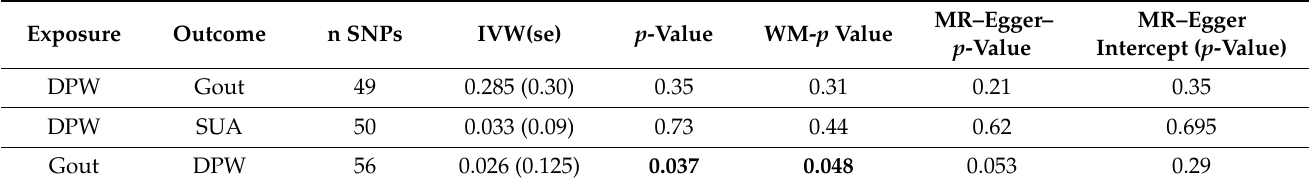
Table 1. Summary of results from the Mendelian randomization analyses. The main analysis was performed using IVW—inverse variance weighted mendelian randomization analysis (values shown are β -coefficients). Sensitivity analyses were performed: WM—weighted median; MR–Egger mendelian randomization